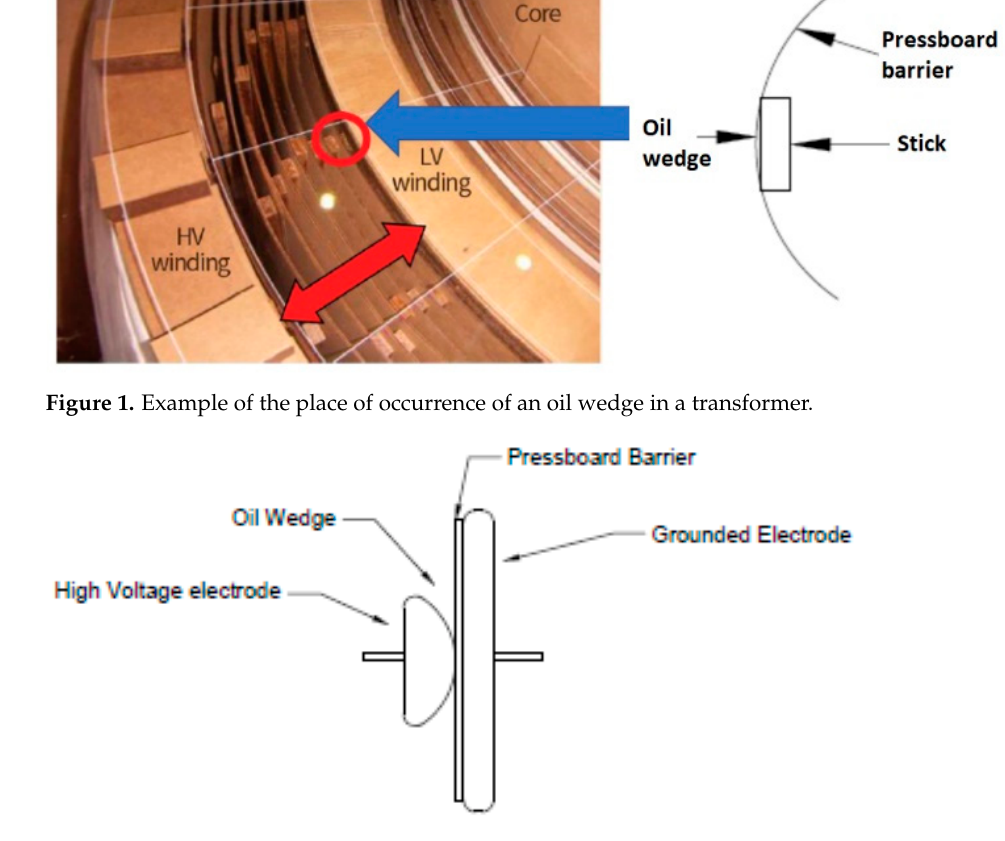
Figure 1. Example of the place of occurrence of an oil wedge in a transformer.